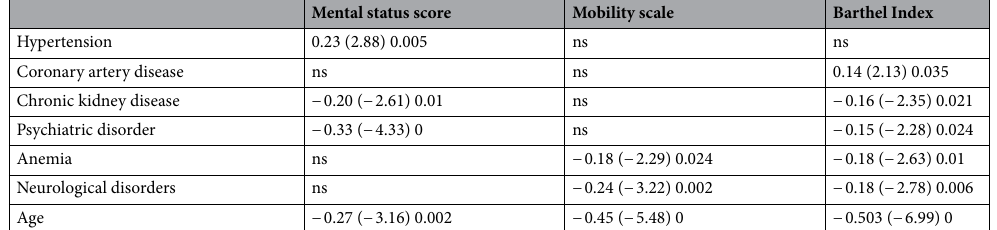
Table 2. Correlation coefficients (standard errors) and p values of functional status scores with demographics, comorbidities, laboratory values, and vital signs. Correlations for comorbidities that had < 6% prevalence were not analyzed as they were unreliable. ns: no